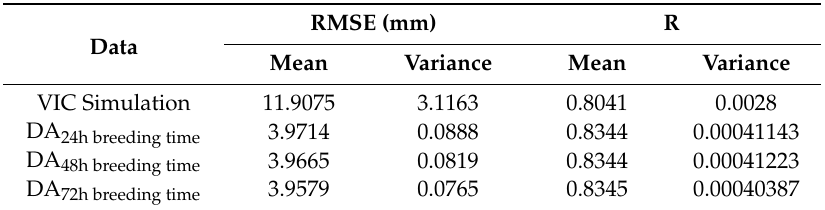
Table 3. The mean and variance of the RMSE and R between the model and the data assimilation experiments with di ff erent breeding time